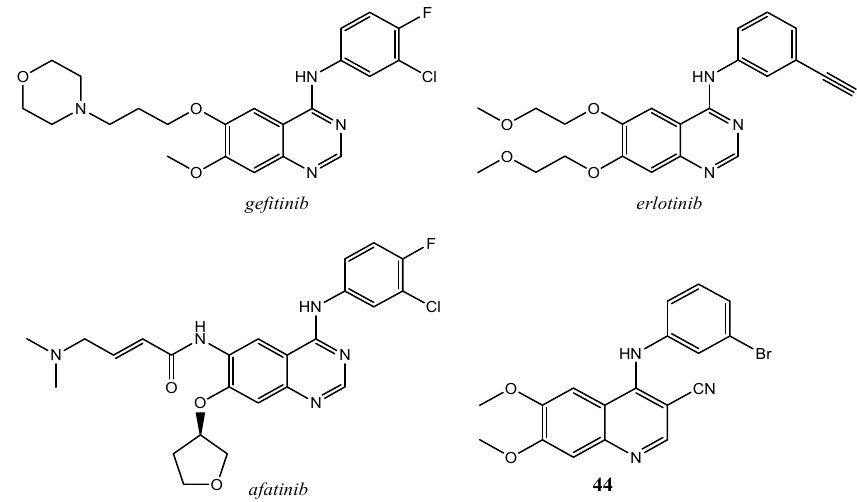
Figure 17. 4-anilinoquinoline-3-carbonitrile 44 and of the approved 4-anilinoquinazoline EGFR inhibitors gefitinib, erlotinib, afatinib .